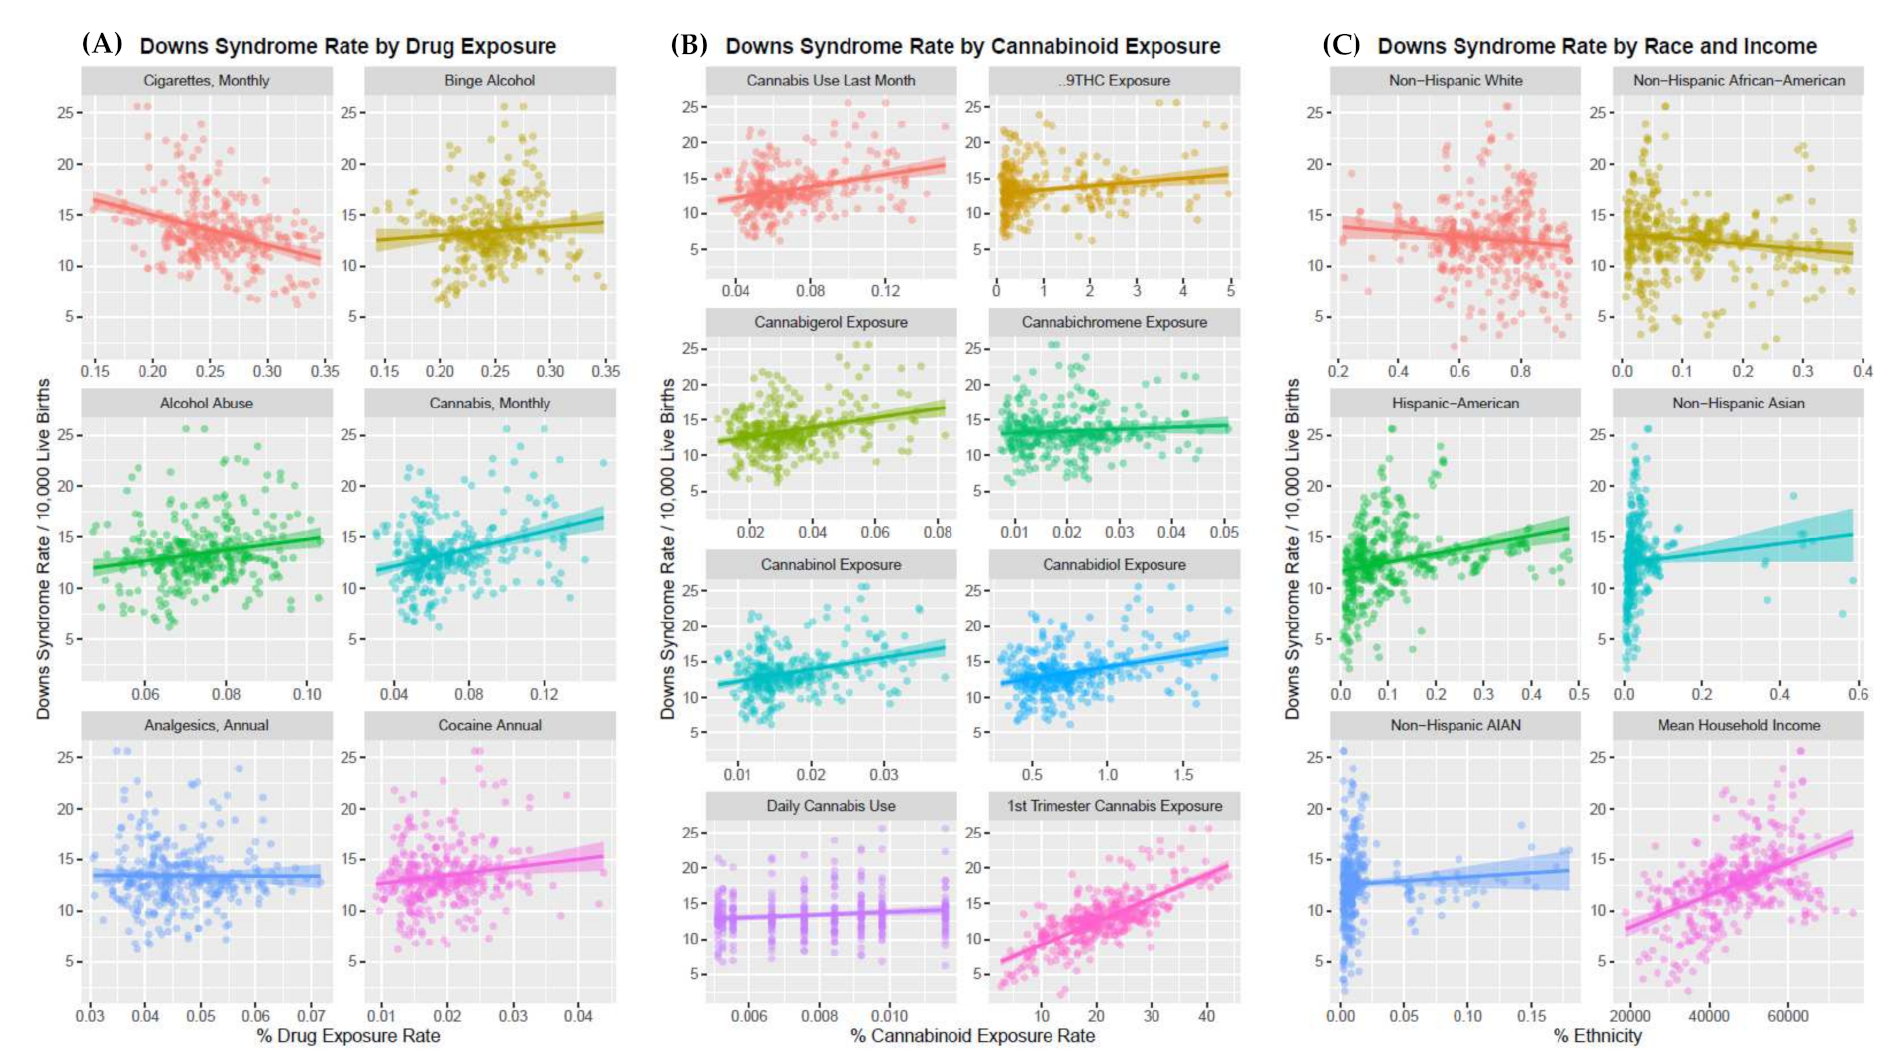
Figure 3. Bivariate plots of the DSR associations. ( A ) Drugs. ( B ) Cannabinoids. ( C ) Ethnicity and Median Household